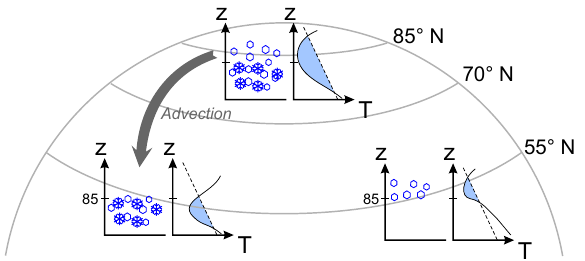
Figure 8. Schematic of the latitudinal differences for ice cloud formation. The x – y plots represent the ice particle distribution with height (left) and the corresponding temperature profile (right). Small particles only visible for the radar are marked by light blue hexagons, larger particles by blue snowflakes. The light blue part of the temperature profile shows the region of supersaturation (dashed: frost point temperature). The altitude of 85 km is marked, forming a typical upper limit of NLCs. Figure 9. Same as Fig. 5, but with different MSE thresholds. Blue,